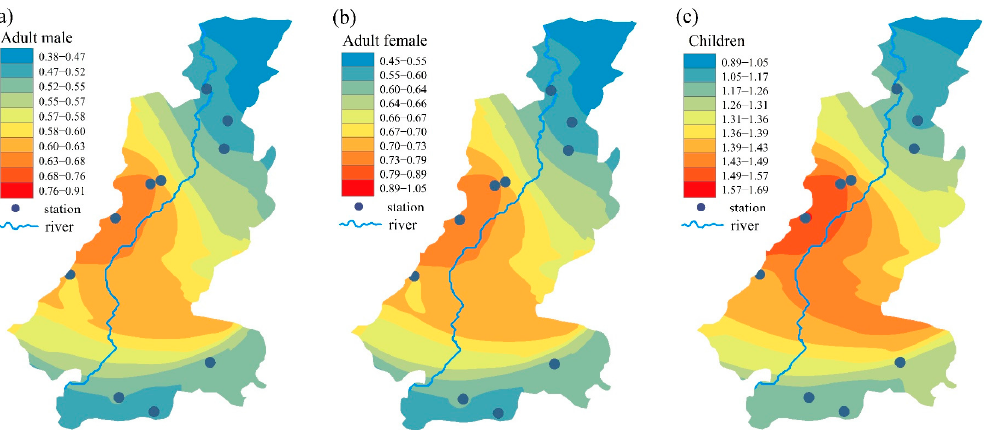
Figure 5. Spatial distribution of non-carcinogenic health risks for males ( a ), females ( b ), and children ( c ).